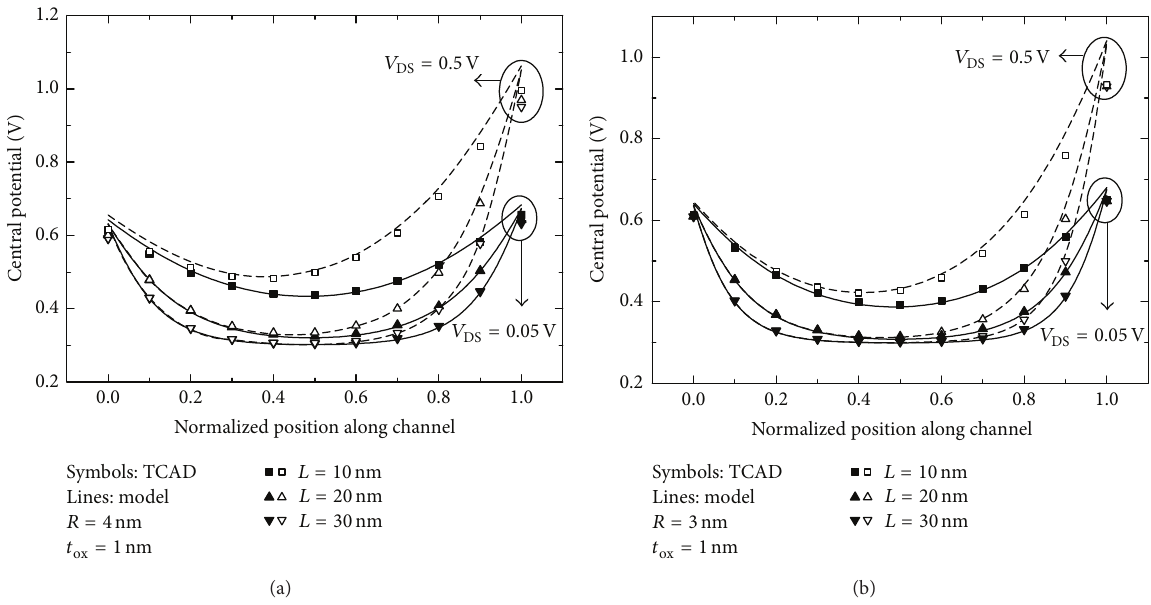
Figure 4: Central electric potential along the channel obtained from the model and TCAD simulation for different gate lengths. Nanowire radius is (a) 4 nm; (b) 3nm. The other device parameters are obtained from Table 1. The solid lines and symbols are for drain bias of 0.05 V; the dashed lines and open symbols are for drain bias of 0.5